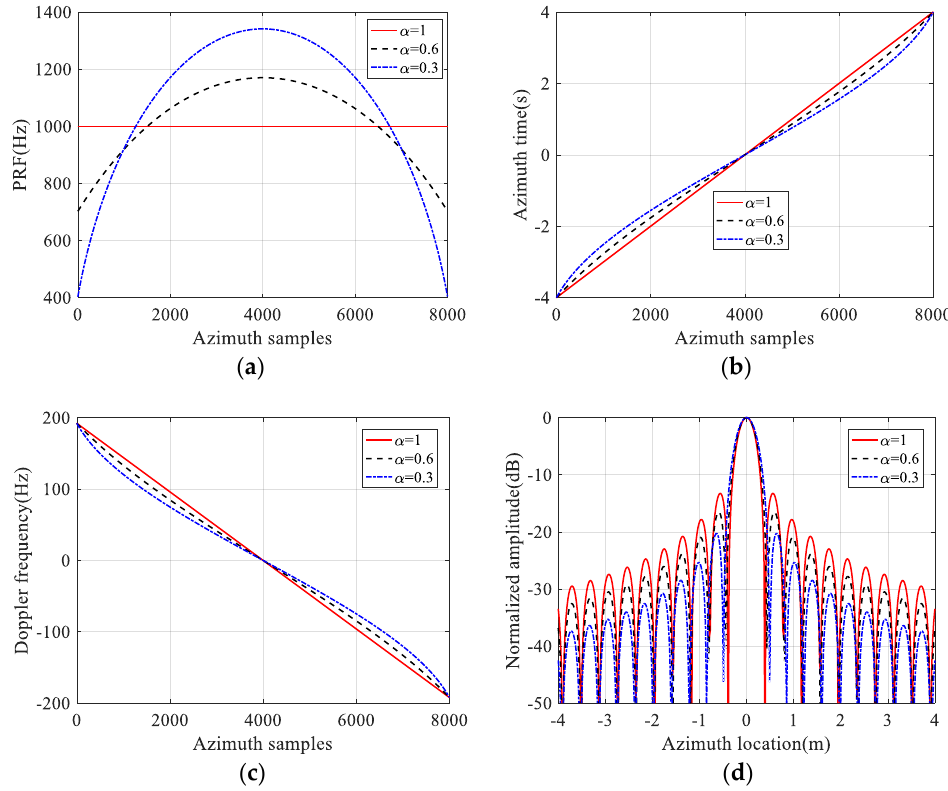
Figure 4. ANUS design results based on the selected raised cosine window function. ( a ) Continuous PRF Variation. ( b ) Azimuth time non-uniform sampling. ( c ) Doppler frequency sampling distribution. ( d ) Azimuth pulse compression results based on different ANUS design results.